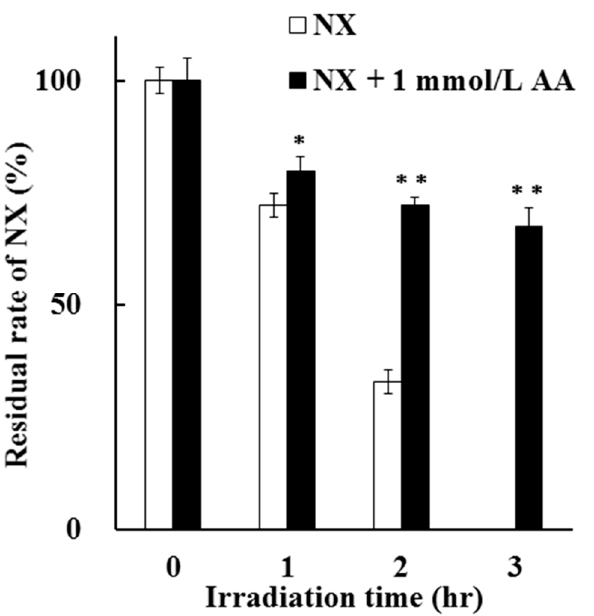
Figure 4. Photoprotective effect of 1 mmol/L AA on NX photodegradation in a solution for up to 3 h. The values represent the mean ± S.D. ( n = 3). * Difference compared with NX ( p < 0.05). ** Difference compared with NX ( p < 0.01).